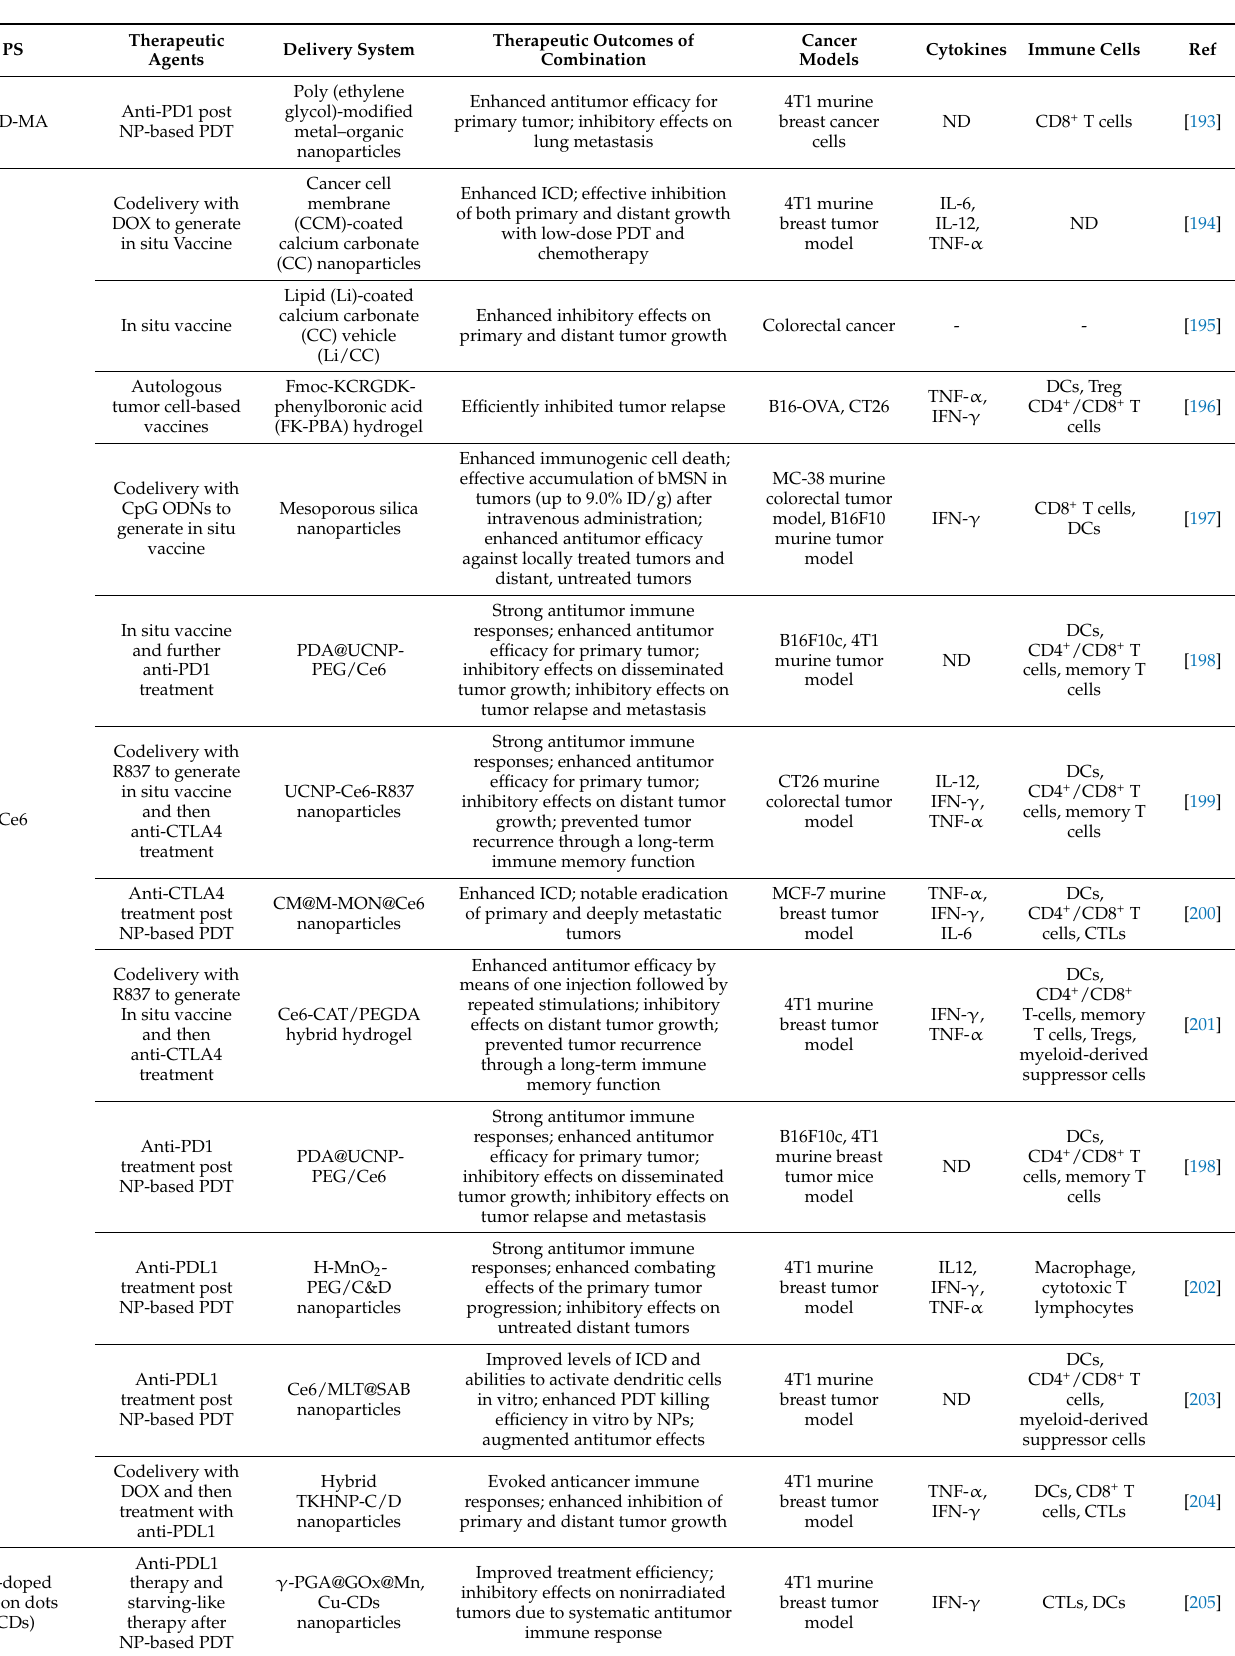
Table 4. Preclinical studies on PDT plus